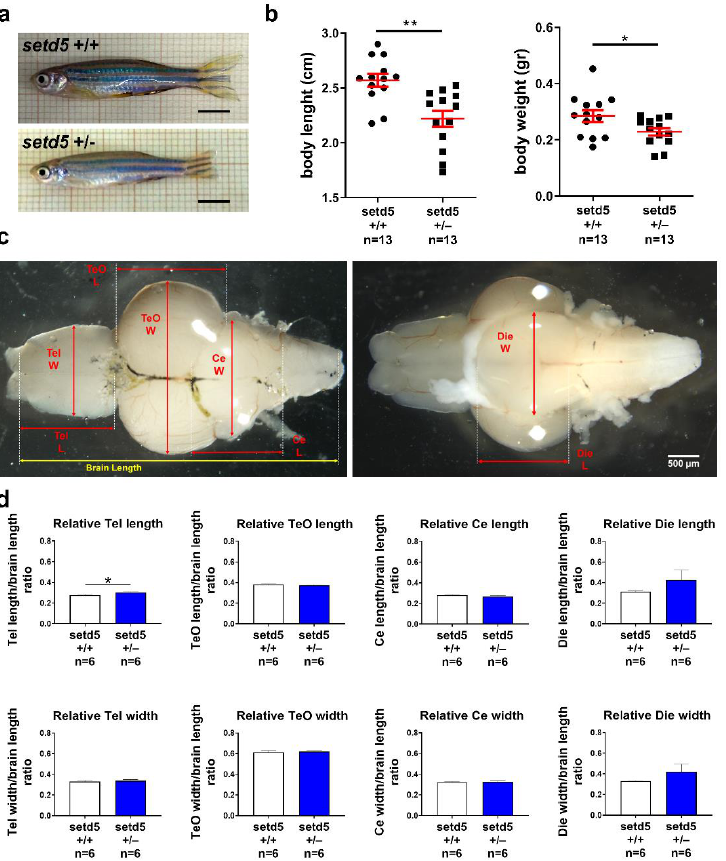
Figure 3. setd5 haploinsufficiency causes a growth delay in adult mutant zebrafish. ( a ) Representative images of 10-month-old setd5 +/+ and setd5 +/ − zebrafish adults. Scale bar 500 μm. ( b ) Body length and body weight analysis in setd5 +/+ and setd5 +/ − 10 months-old zebrafish adults. n = number of adults analyzed. ( c ) Representative images of adult brains from 10-month-old setd5 +/+ zebrafish adults, evidencing the different measurements conduced for the morphometrical analysis included in ( d ). W, width; L, length. ( d ) Relative Telencephalon (Tel) length and width, Optic tectum (TeO) length and width, Cerebellum (Ce) length and width, Diencephalon (Die) length and width in adult brain, normalized to the entire brain length, from 10-month-old setd5 +/+ zebrafish adults. Absolute values are included in Figure S5. ( d ) n = number of adult brains analyzed. Data are expressed as mean ± SEM. Statistical analysis was performed by Student’s t -test. * p < 0.05; ** p <